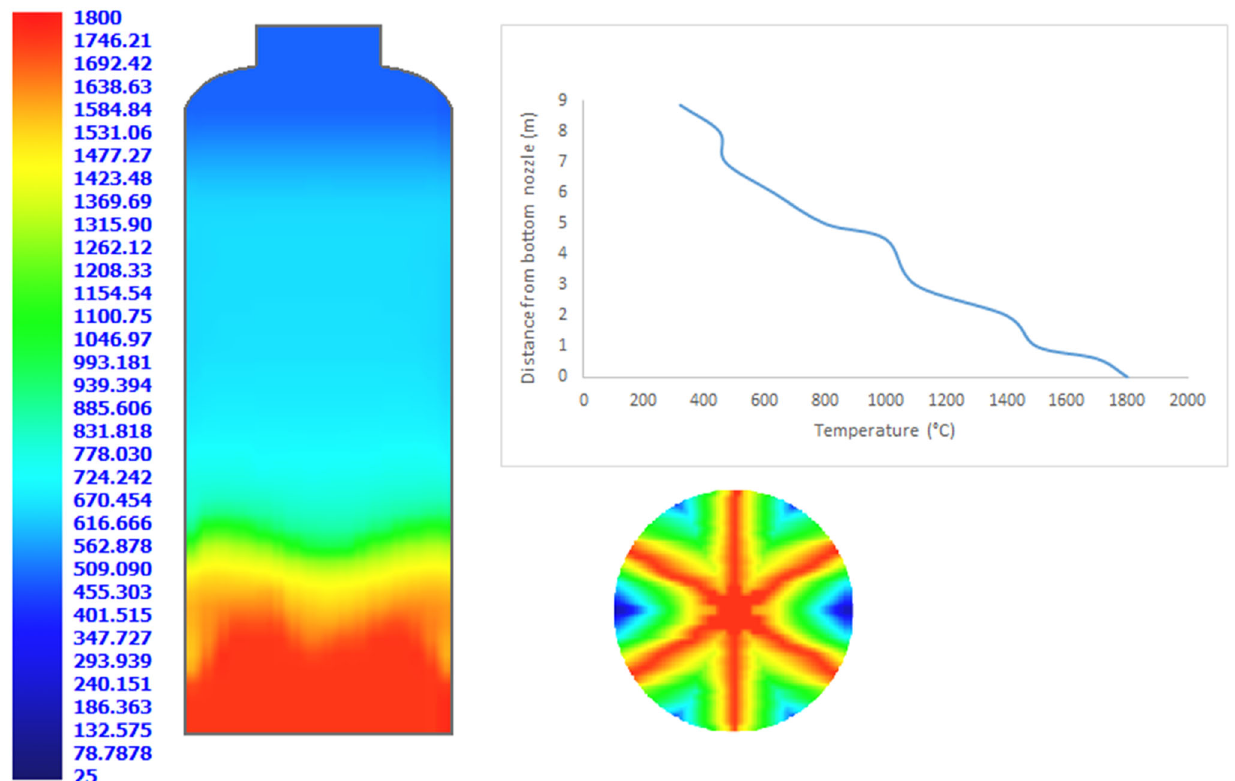
Fig. 7 Temperature contour distribution in the